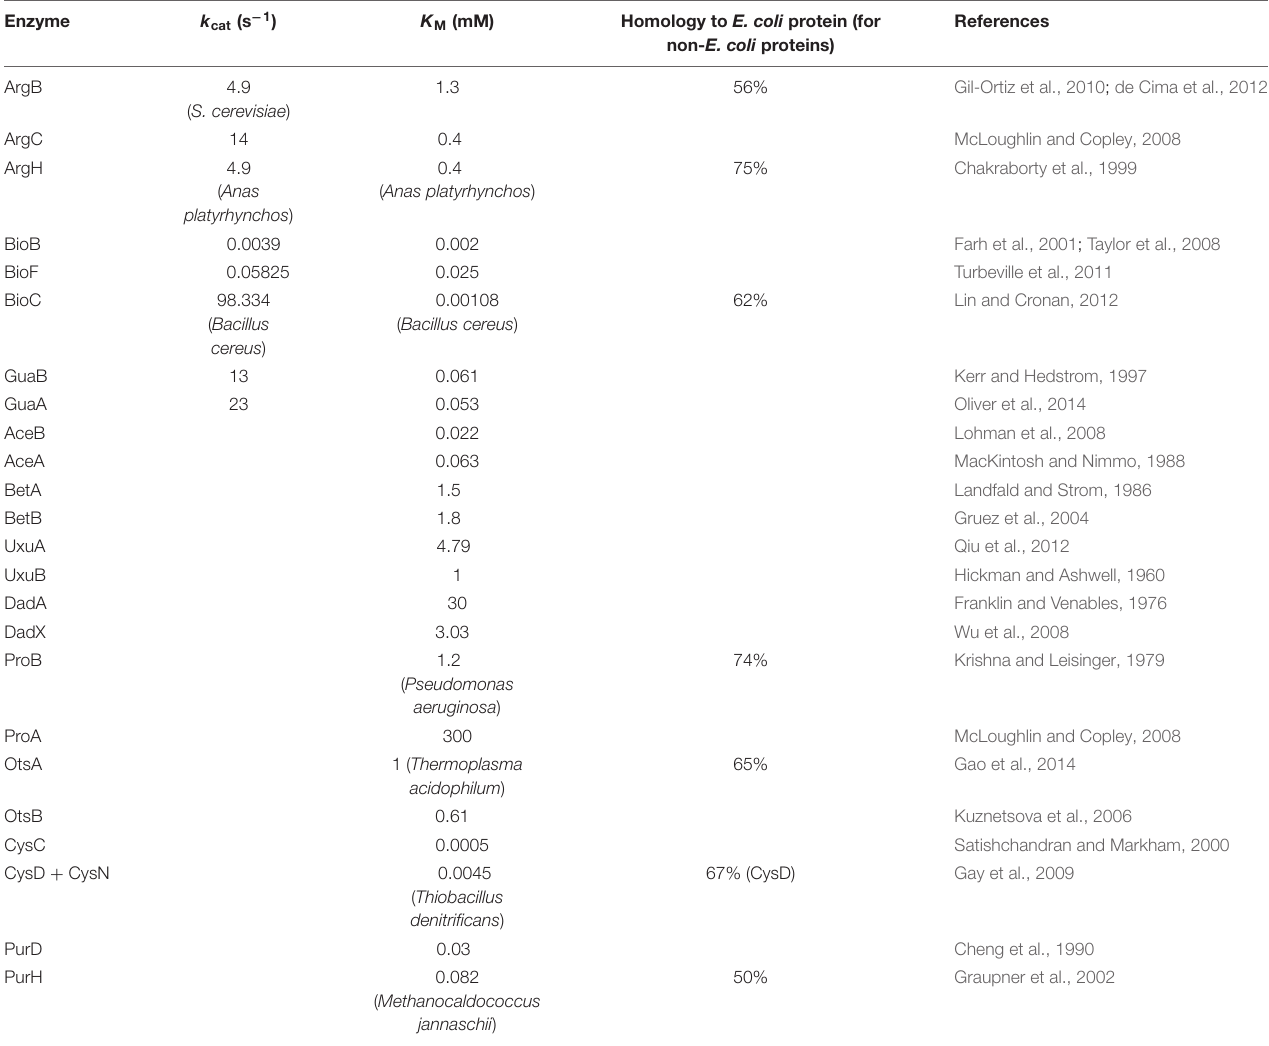
TABLE 1 | Kinetic parameters of the enzymes in one metabolic pathway. Enzyme k cat (s − 1 ) K M (mM) Homology to E. coli protein (for